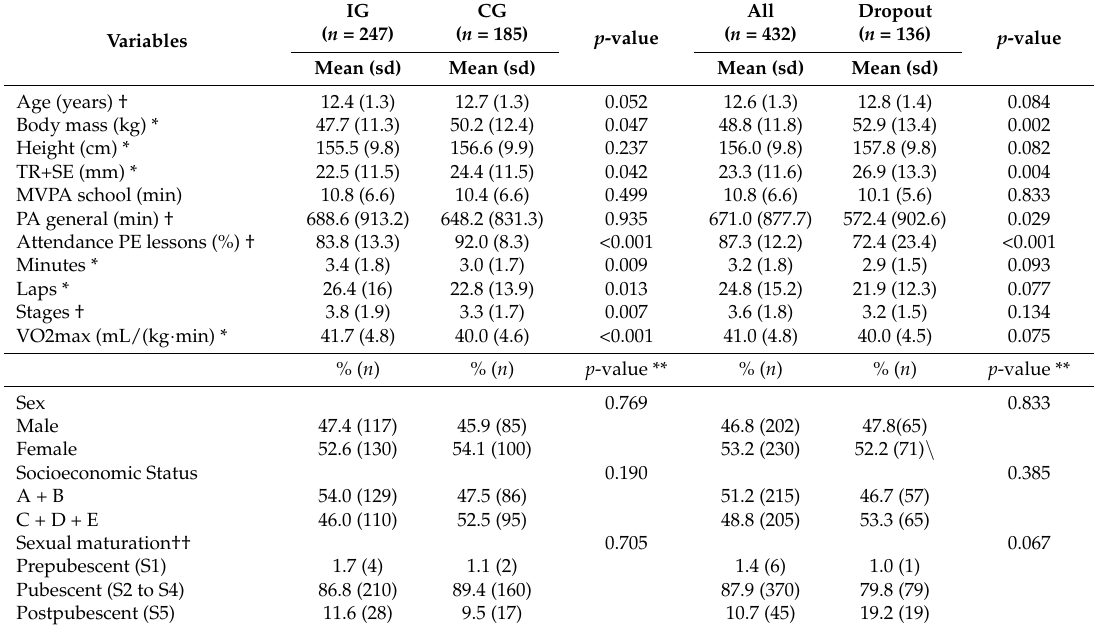
Table 2. Baseline physical and sociodemographic characteristics, and physiological measures in intervention and control groups in Brazilian students. Florianopolis, SC, Brazil, 2015.